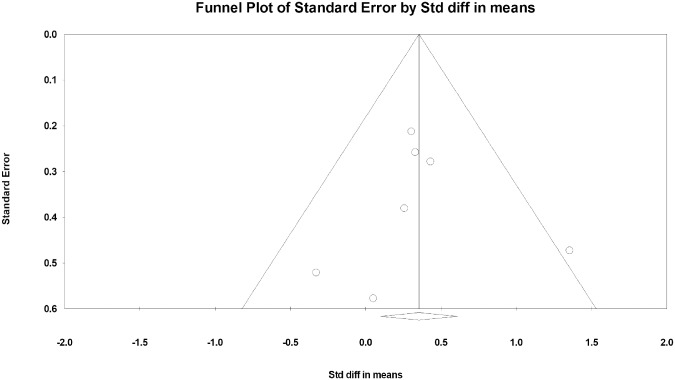
Publication bias.